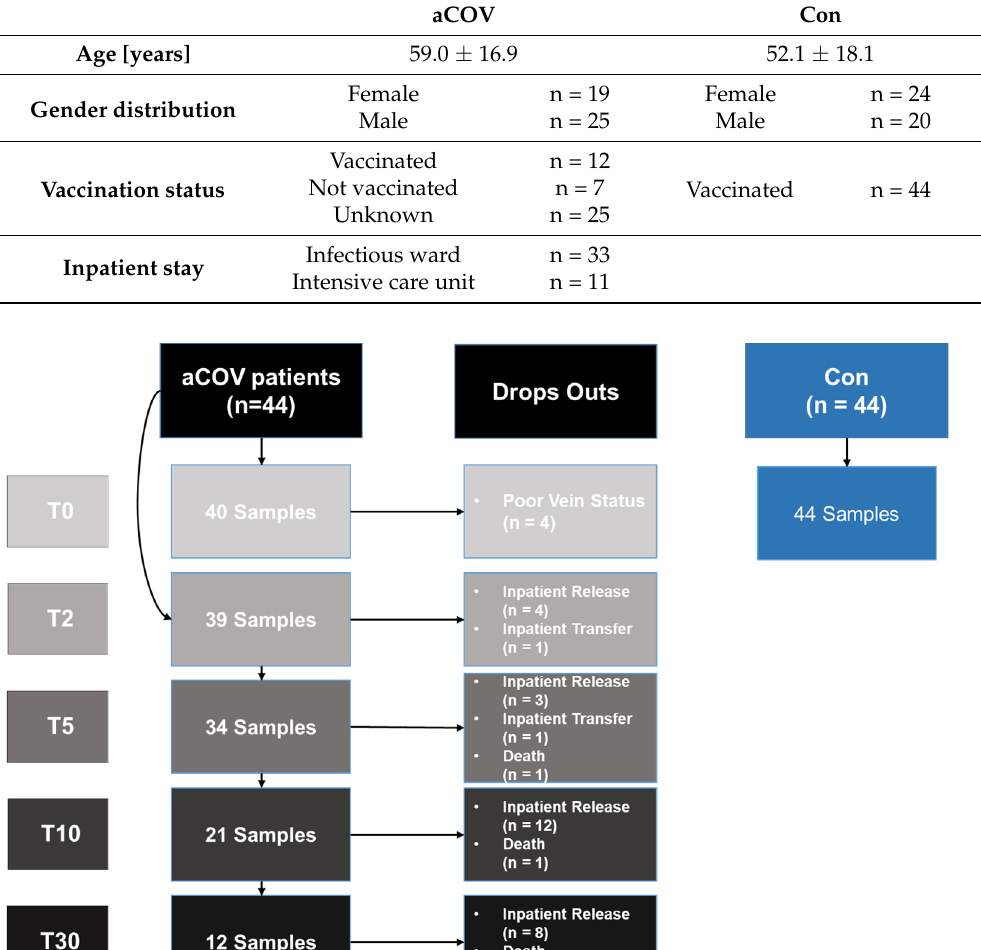
Table 1. General characteristics of acute infected and severely ill COVID-19 patients (aCOV) and an age-matched healthy control group (Con). All data are presented as mean ± Standard Deviation.